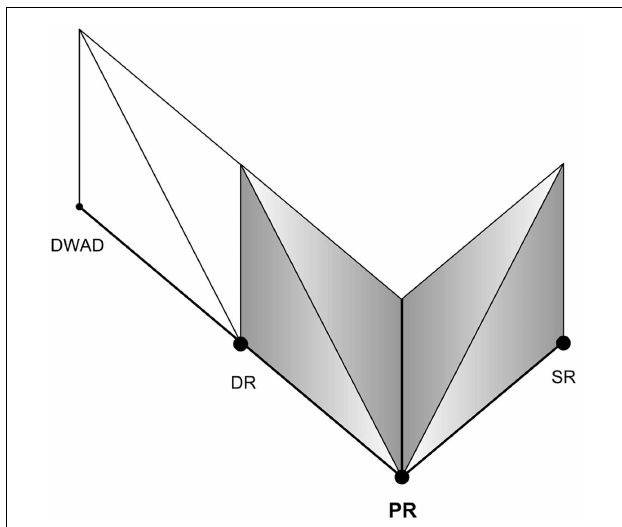
FIGURE 14 | Reality continuum (illustrating the levels of